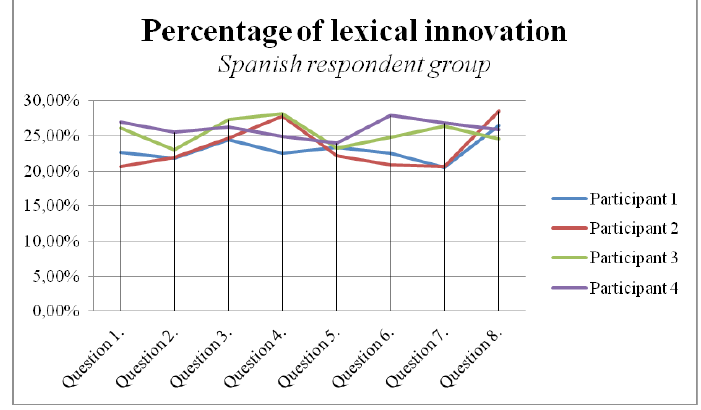
Graphic 6: Percentage of lexical innovation - English respondent group.